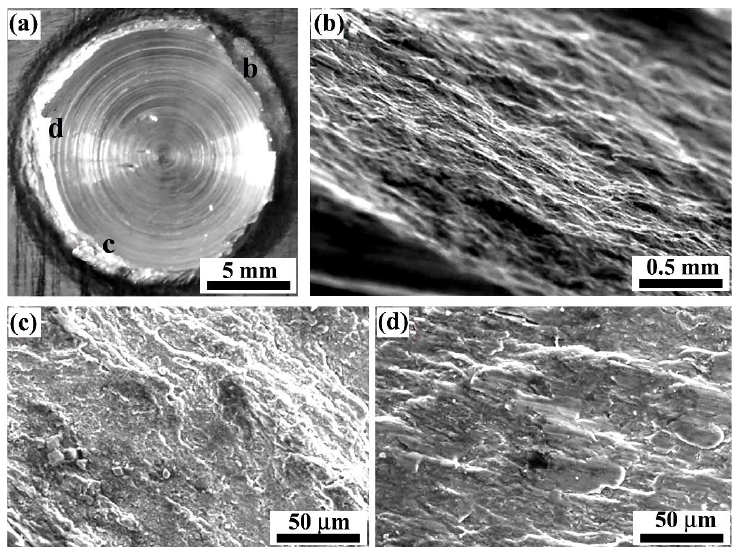
Figure 9. SEM images of the fracture surfaces in the R-FSSW sample at tool rotational speed of 900 rpm: ( a ) Fracture surface on the lower sheet; ( b – d ) magnified views at points ( b – d ) in ( a ), respec- tively.